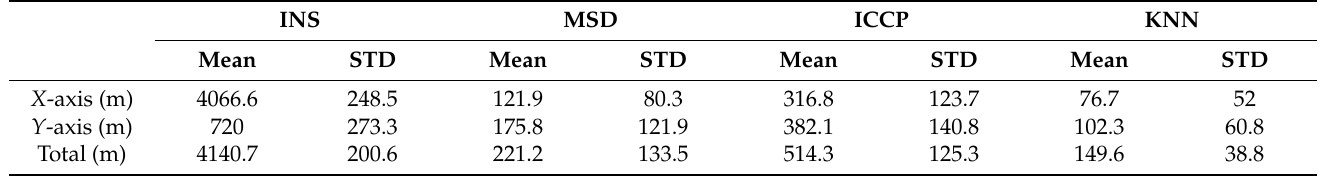
Figure 5. Matching results of track 1. Table 2. Statistics of positioning errors of track 1/m.